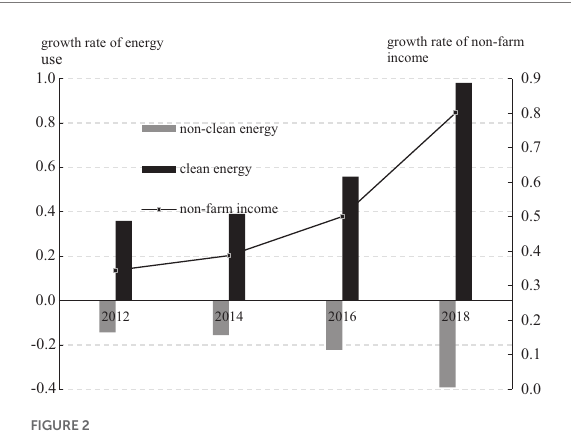
FIGURE 2 Trends in non-farming income and energy use